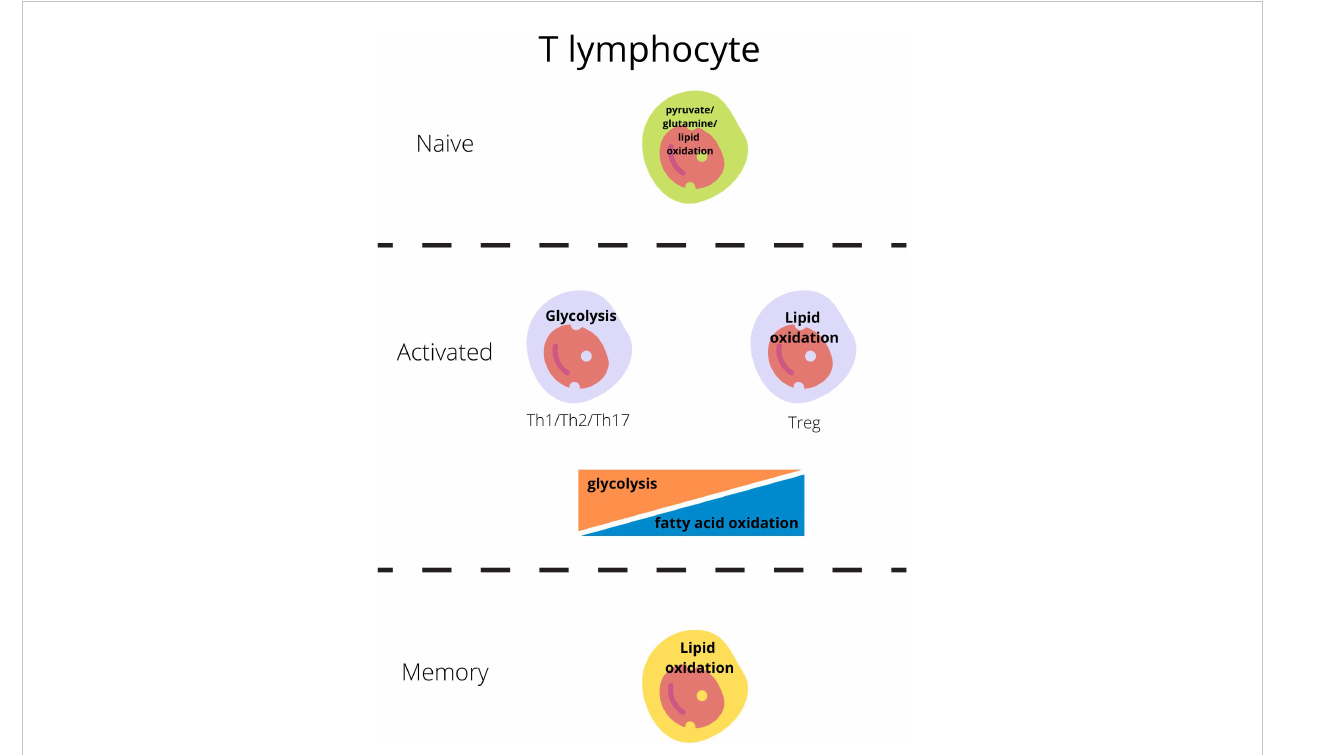
FIGURE 1 Main metabolic pathways responsible for energy production in T lymphocytes regarding their activity state (21,